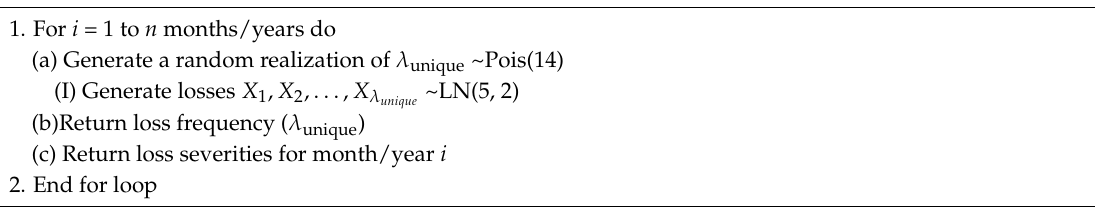
Algorithm A3 Procedure for generating synthetic data corresponding to Scenario (III) 1. For i = 1 to n months/years do